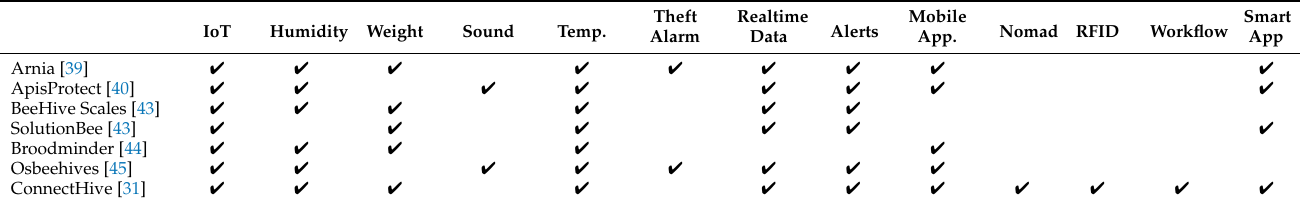
Table 2. Similar solutions